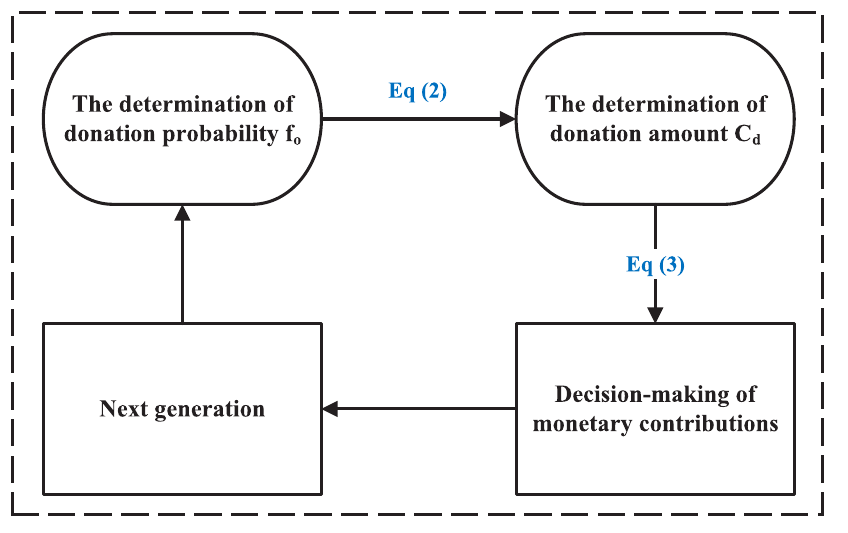
Fig 2. The circulatory process of decision-making of dedicators. Dedicators’ contributions include monetary and non-monetary contributions. Decision-making of monetary contributions requires determining in advance the possibility and amount of